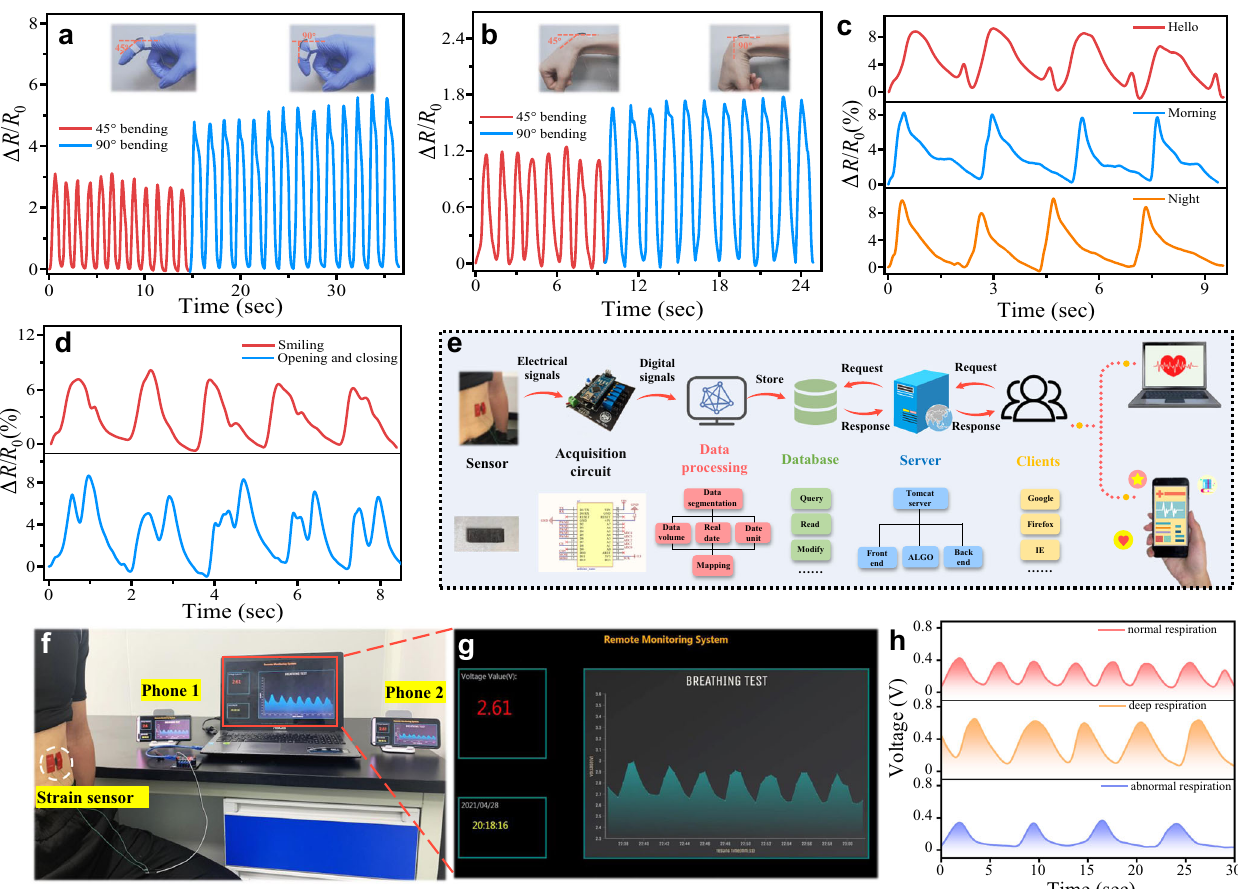
Fig. 5 Wide-range physiological signals detection and respiration monitoring using a cloud platform. Relative resistance changes with a index fi nger bending, b wrist bending, c phonating ( ‘ Hello ’ , ‘ Morning ’ and ‘ Night ’ ), d subtle facial expressions movements (smiling and opening and closing mouth). e Schematic illustration of big data cloud monitoring platform. f Photograph showing the strain sensor placed on the abdomen for measuring the respiratory signal. g Big data platform display interface h Three different respiration signals of a volunteer on the cloud data